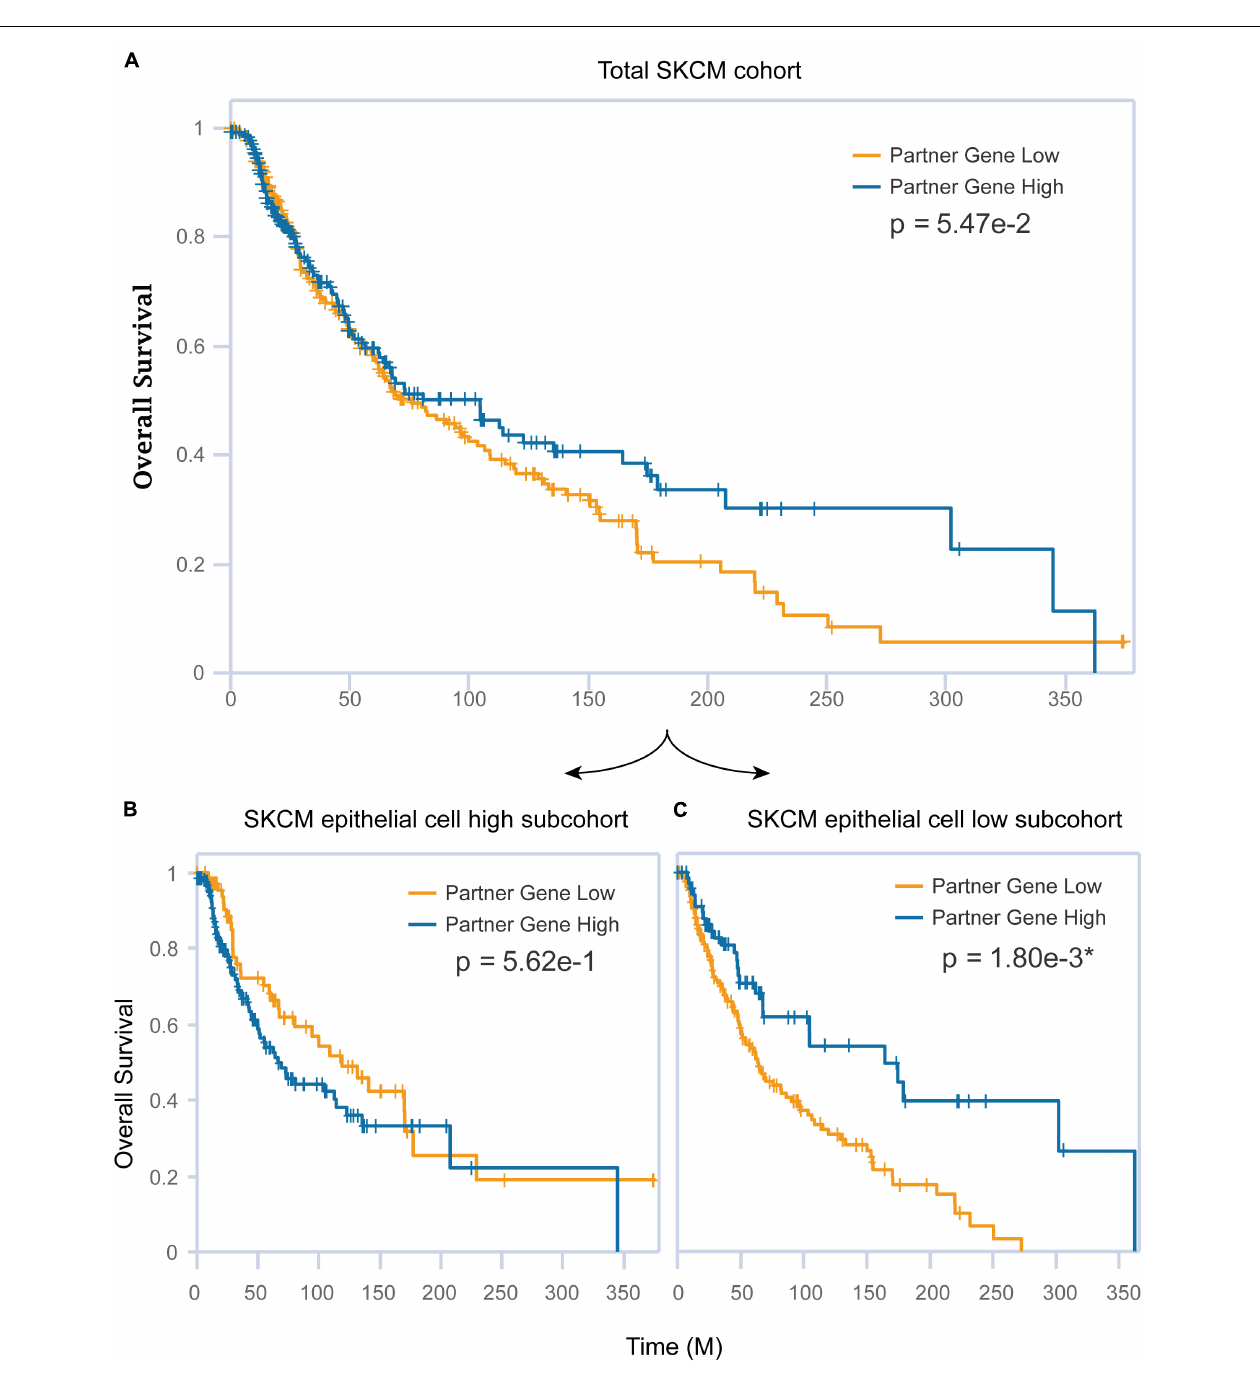
FIGURE 7 | The combination of CST6 expression and epithelial cell infiltration predicted the prognosis for SKCM patients. (A) Kaplan–Meier estimates of overall survival (OS) for the total SKCM cohort based on CST6 expression. (B) Kaplan–Meier estimates of OS for the SKCM epithelial cell high subcohort based on CST6 expression. (C) Kaplan–Meier estimates of OS for the SKCM epithelial cell low subcohort based on CST6